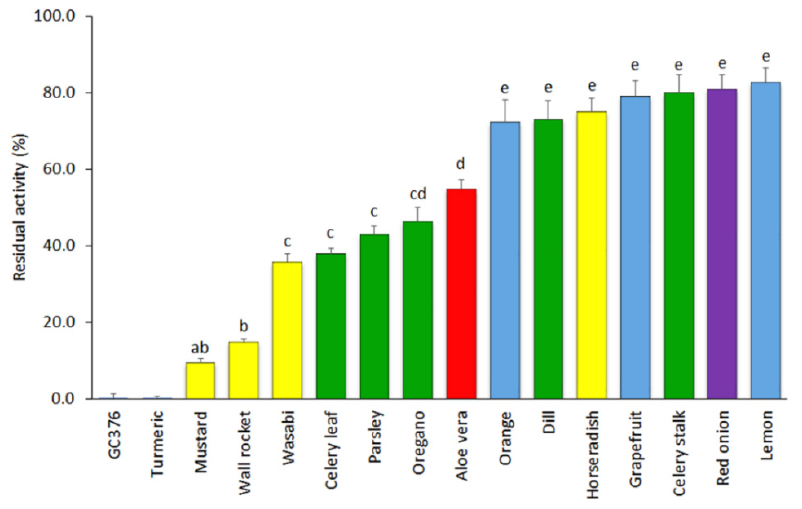
Figure 1. Mean values and standard errors (SEs) for the residual activity of SARS-CoV-2 3CL Pro in the presence of the fifteen plant-based extracts at a concentration of 500 µ g mL − 1 and the inhibitor control GC376 at a concentration of 50 µ M ( n = 4). Extracts included were obtained from citrus fruit peels (blue), seasoning and aromatic herbs (green), bulbs and rhizomes (purple; includes turmeric), a succulent plant (red), and cruciferous herbs and condiments (yellow). Both the turmeric extract and the inhibitor GC376 produced a complete inhibition of the 3CL Pro . Different letters indicate significant differences in the 3CL Pro residual activity according to a Student–Newman–Keuls test at p < 0.05.